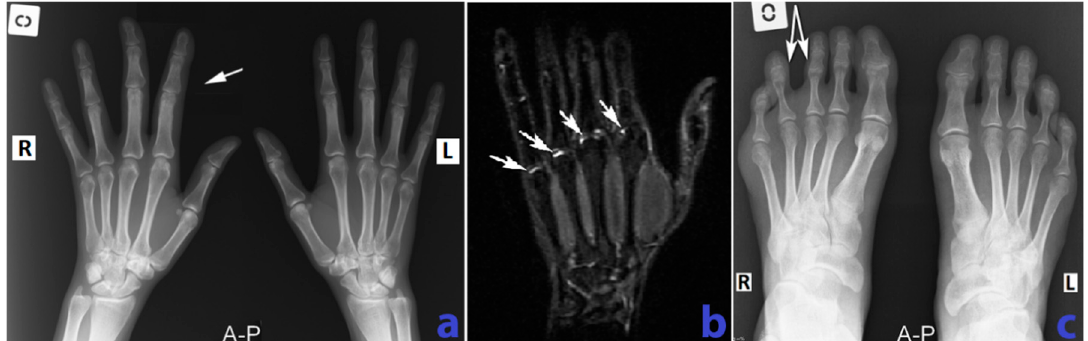
Figure 2. ( a ) Comparative x-ray of the hands, AP (anteroposterior) view shows mild “band like” osteoporosis adjacent to the MCP (metacarpophalangeal) joints, bilateral and slightly enlarged 2nd and 3rd finger on the right hand associated with slight ulnar deviation of the third finger. ( b ) MRI of the right hand, STIR (Short Tau Inversion Recovery) sequence, coronal view demonstrates mild fluid collections in the metacarpophalangeal joint spaces (white arrows). ( c ) Comparative x-ray of the feet AP view shows enlargement interdigital space with “sandal gap” appearance between the 3rd and the 4th right toes (white arrows). R—right, L—left.